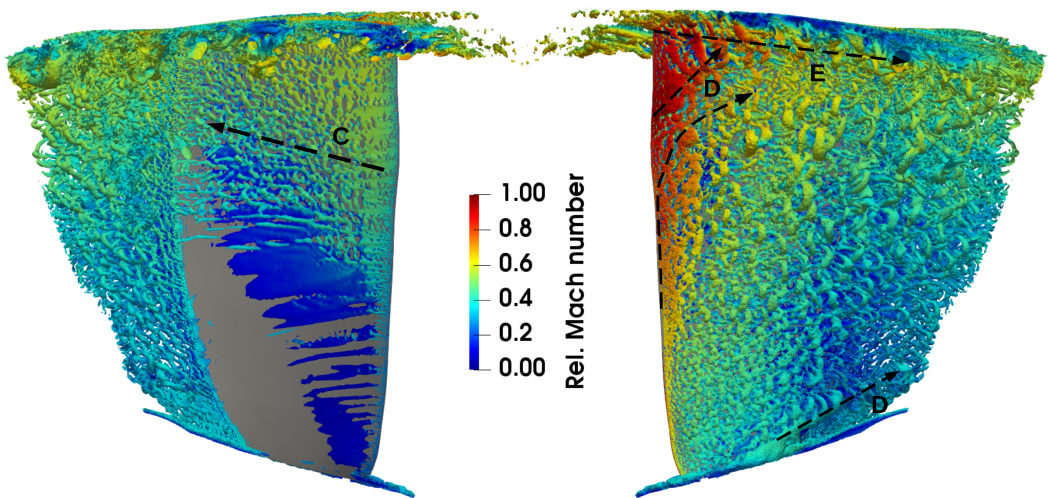
Figure 9. Iso-surfaces of the Q-criterion (10 − 7 s − 2 ) around the blade. Left : pressure side. Right : suction side.